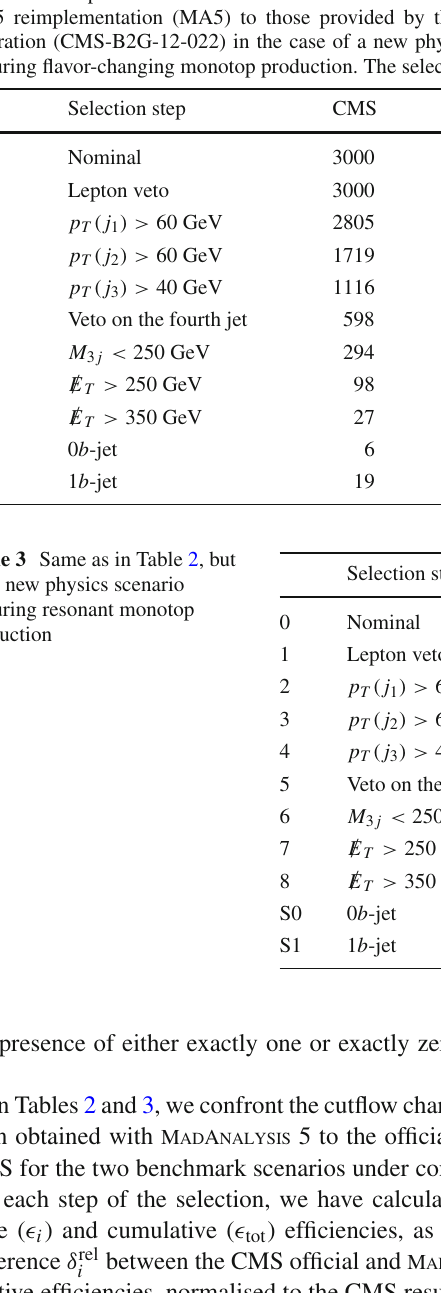
Table 2 Comparison of results obtained with our MadAnaly- sis 5 reimplementation (MA5) to those provided by the CMS col- laboration (CMS-B2G-12-022) in the case of a new physics scenario featuring flavor-changing monotop production. The selection and total